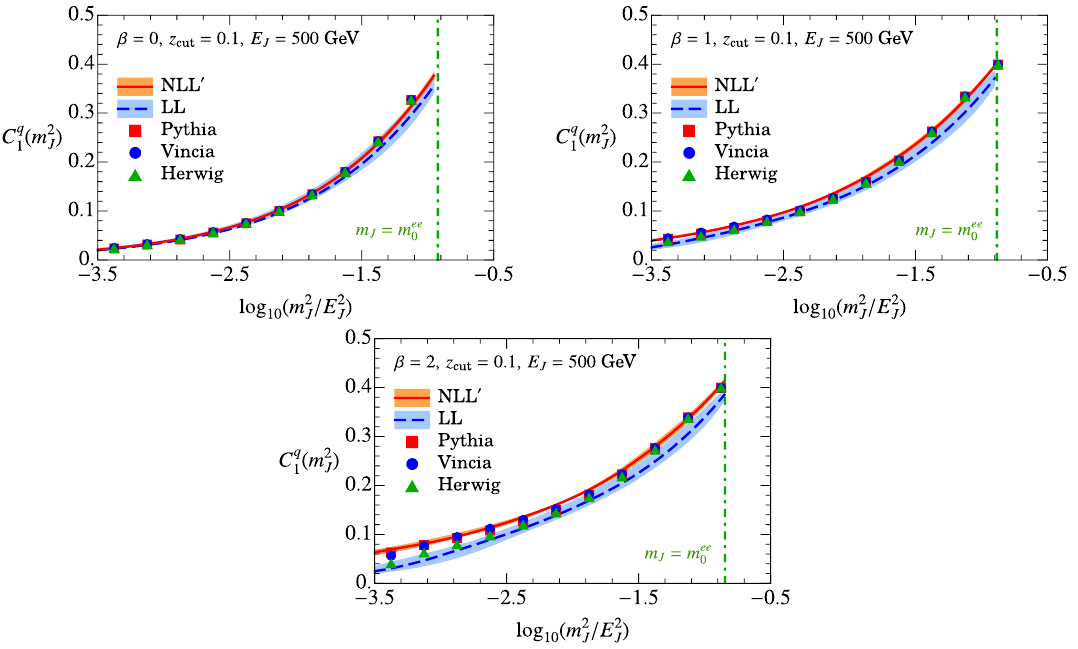
Figure 9 . Uncertainty estimate for the NLL 0 and LL effective theory predictions for the perturba- tive coefficient C q . We do not estimate LL uncertainty in the ungroomed region, where the EFT 1 description loses validity. NLL 0 uncertainty bands are tiny and examined in more detail in figure